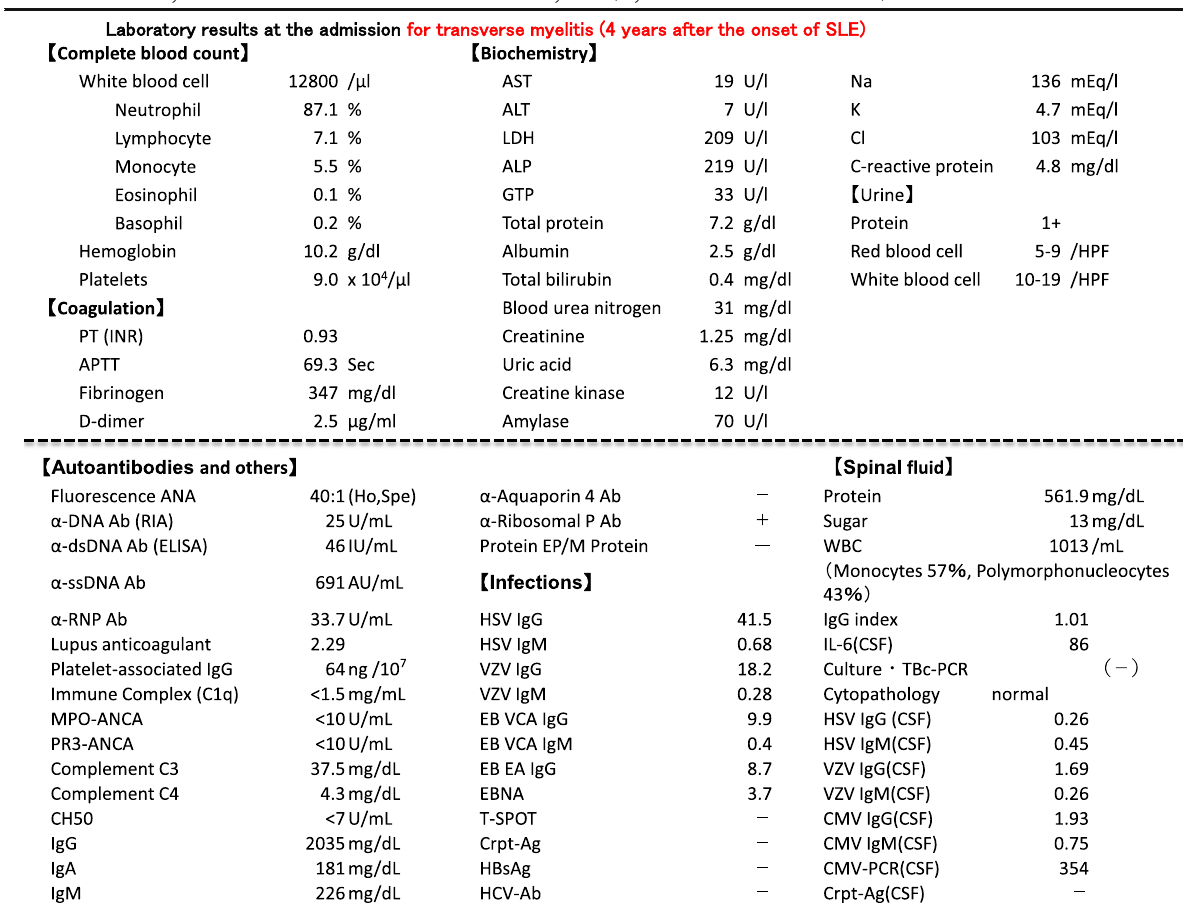
Table 1 Laboratory results at the admission for transverse myelitis (4 years after the onset of